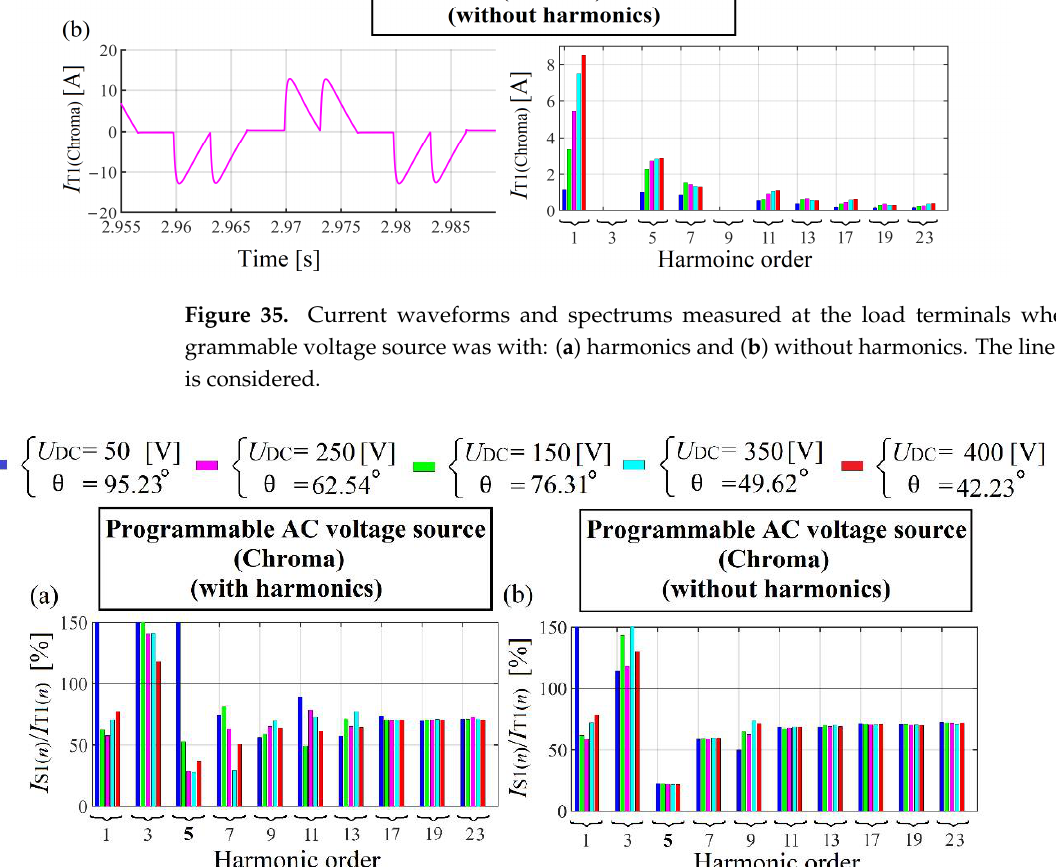
Figure 36. Filter efficiency when the programmable voltage source was with: ( a ) harmonics and ( b ) without harmonics. The line reactor L SS is considered.